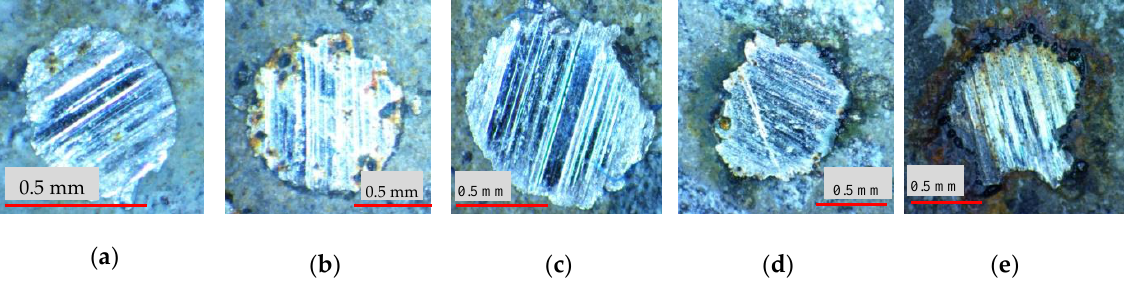
Figure 14. Observations of the interface zones between steel fibers and concrete matrix which specimens encountered no spalling by an optical microscope. ( a ) SF1; ( b ) SF2; ( c ) SF3; ( d ) RSF; ( e ) RSFR.